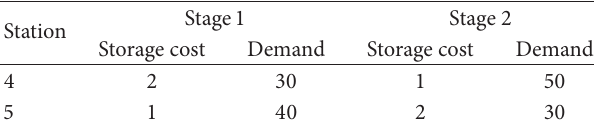
Table 4: Storage cost and demand in destination stations.